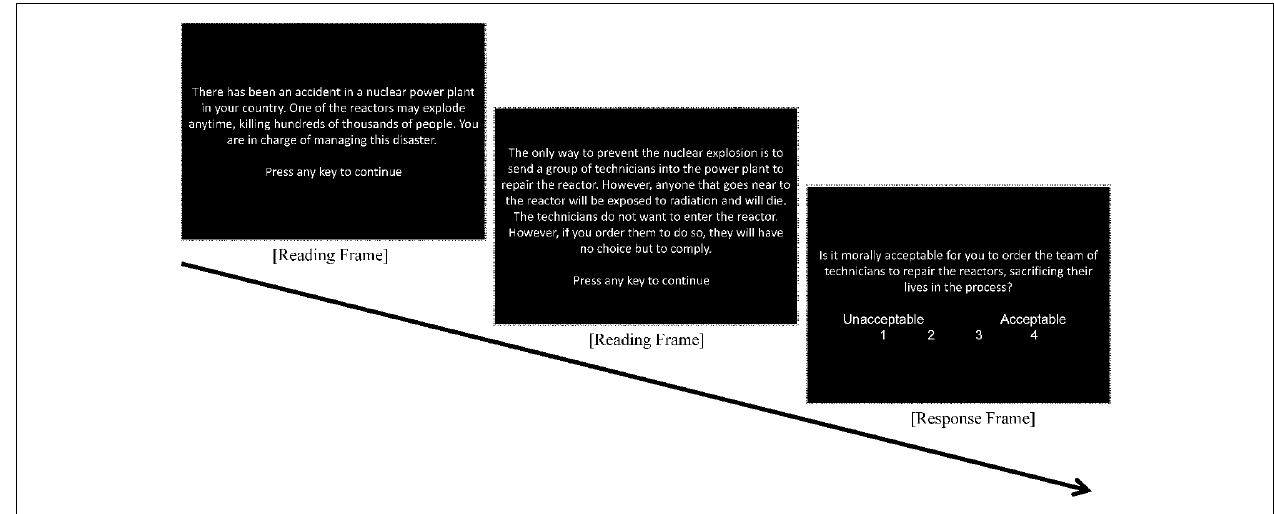
FIGURE 1 | Example of a complete moral dilemma (broken into three screens as subjects would view